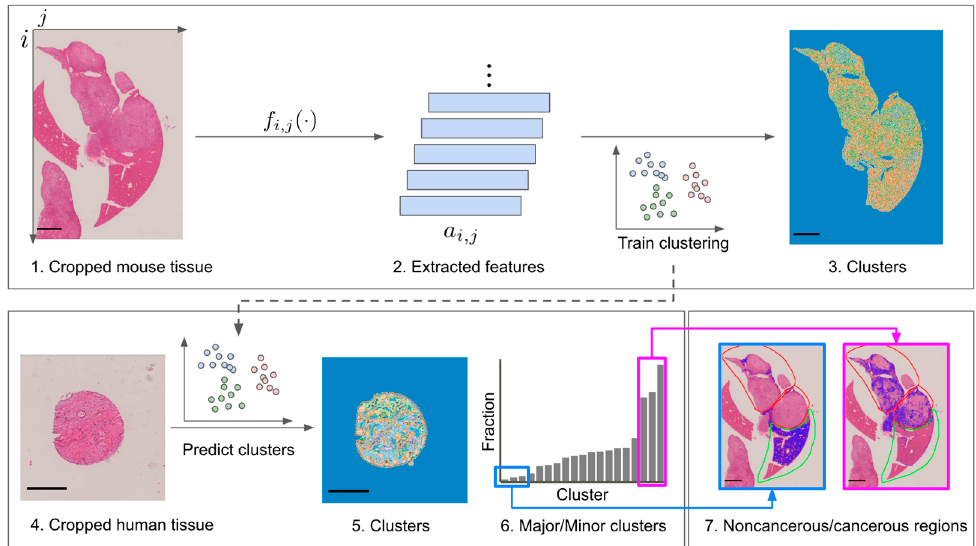
Figure 2. Overview of homology analysis for mouse and human histopathologic images ( n = 5 and n = 90, respectively). Multiscale basic features (MBFs) were extracted for each pixel in cropped images of mouse tissue (see Section 2), after which KMeans clustering was performed with a cluster size of 30. Major/Minor clusters were obtained from predicted clusters for human tissue. Scale bars are 2.0 mm for mouse tissue images and 0.5 mm for human tissue images.